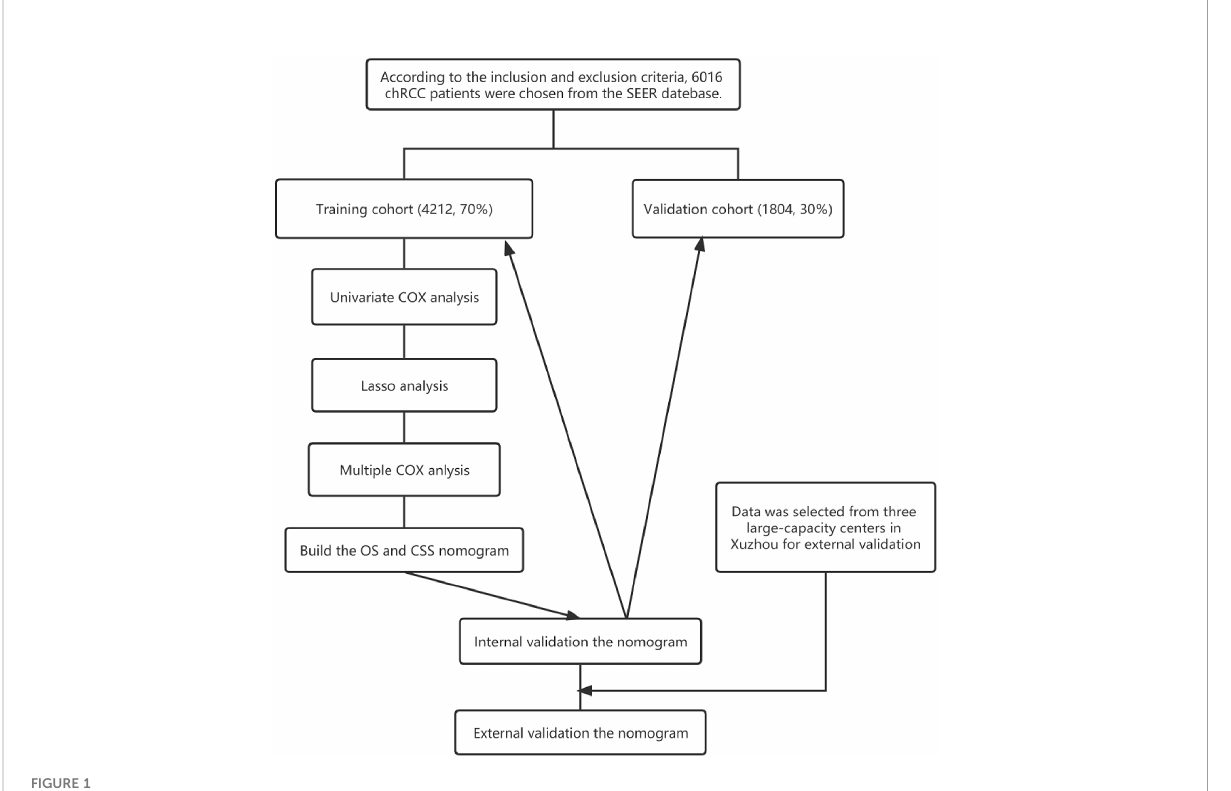
FIGURE 1 Flowchart of the study.